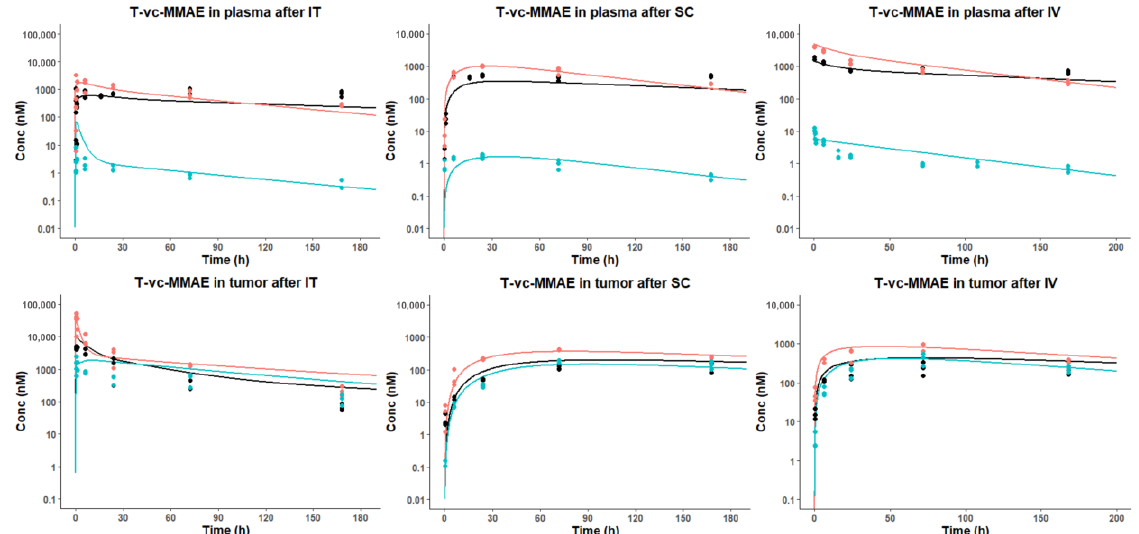
Figure 7. Comparison of model fitted and observed PK profiles of T-vc-MMAE analytes in plasma and tumors after intravenous (IV), intratumoral (IT), and subcutaneous (SC) administration of 10 mg/kg of T-vc-MMAE single dose. The figure displays observed (dots) and model-predicted (solid lines) plasma and tumor concentration vs. time profiles of total antibody (red), total MMAE (black), and unconjugated MMAE (cyan) in